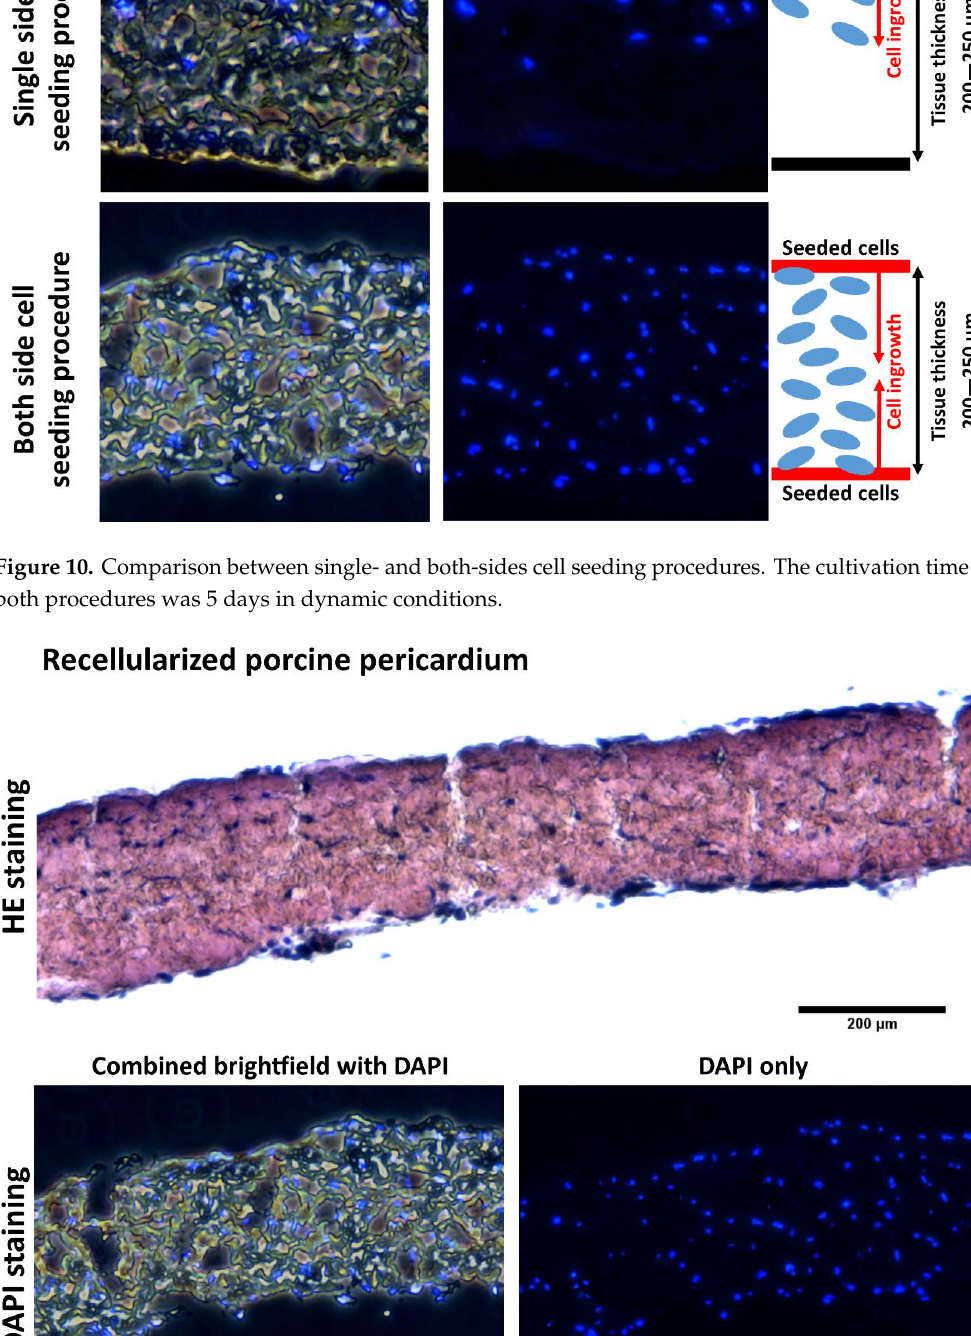
Figure 12. Paraffin-embedded 20 µm sections of ovine recellularized pericardium stained with hematoxylin-eosin (HE) and DAPI. Cells were seeded from both sides of the decellularized tissue prior to dynamic stimulation. Cultivation was held for 5 days in a dynamic culture system.